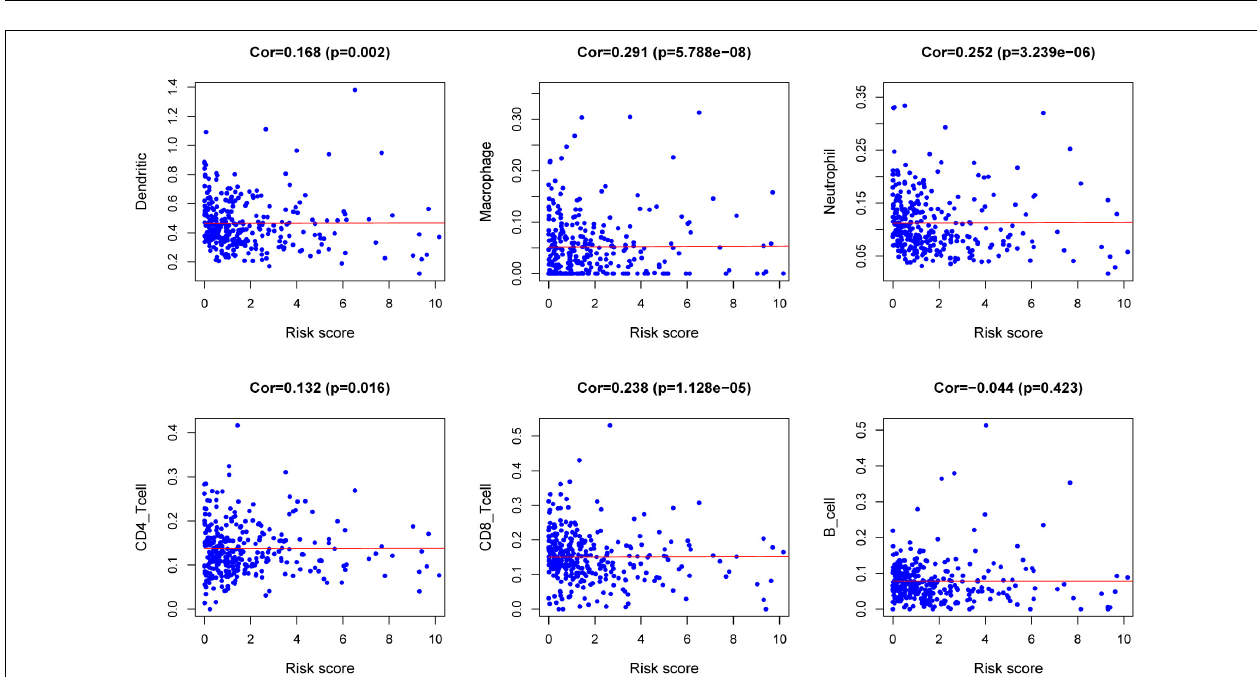
FIGURE 7 | Clinical characteristics correlation analysis. Clinical characteristics correlation analysis of genes in the risk score model ( P < 0.05).